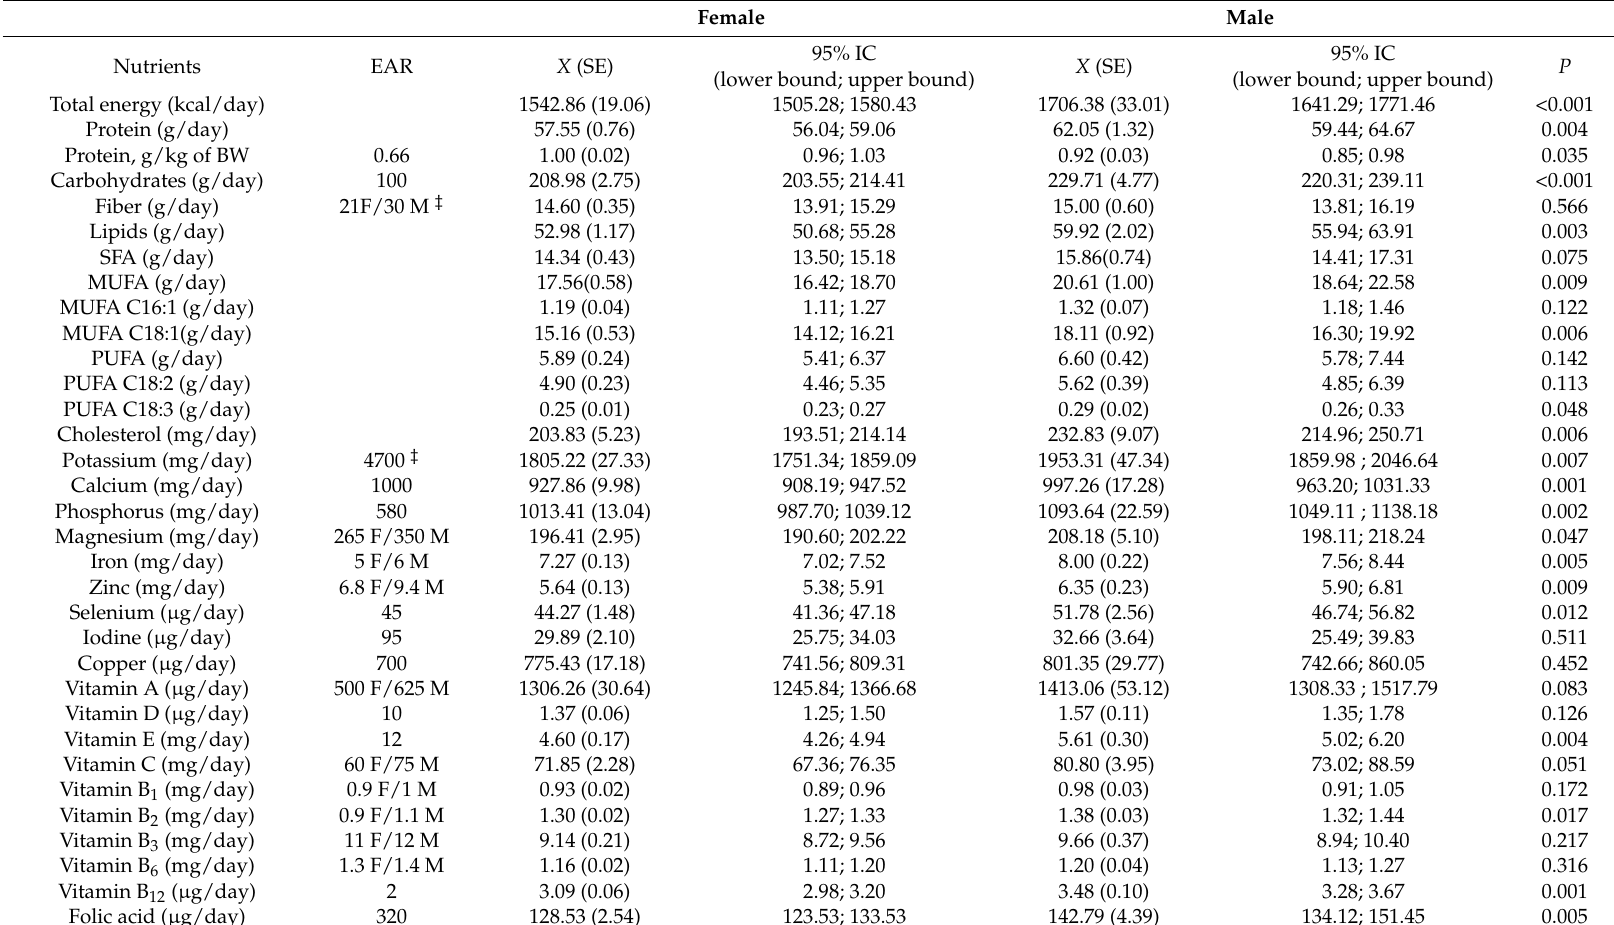
Table 2. Nutrient intake in care home